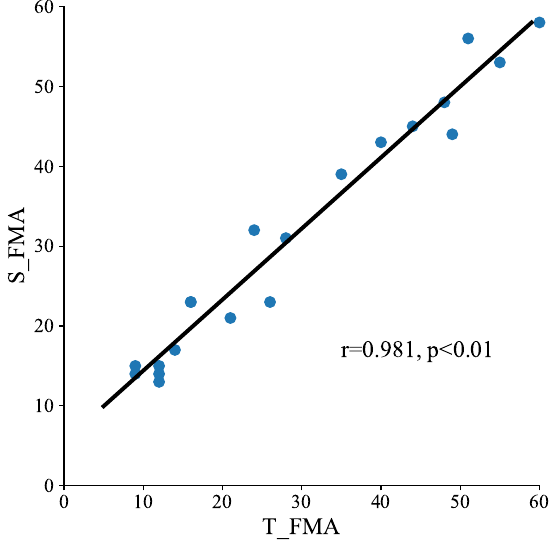
Figure 4. The correlation between the summed scores of the 30 items obtained by the automated system and by a therapist ( n =